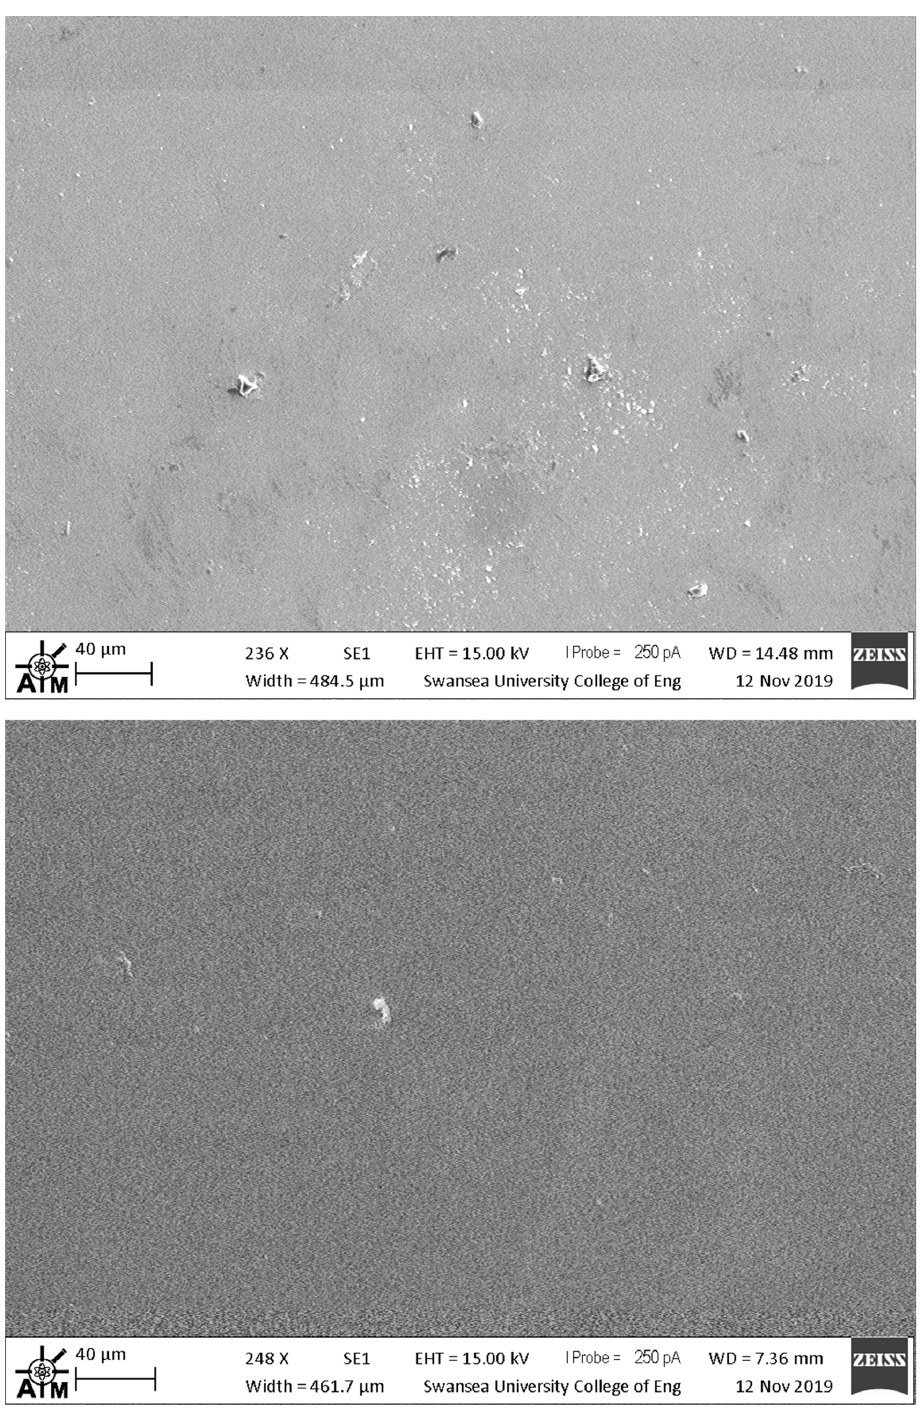
Figure 3. SEM images of mesoporous films of (top) CeO 2 and (bottom) MnO 2 films that were sintered at 550 °C on fluoride ‐ doped tin oxide (FTO) glass. at 550 ◦ C on fluoride-doped tin oxide (FTO)